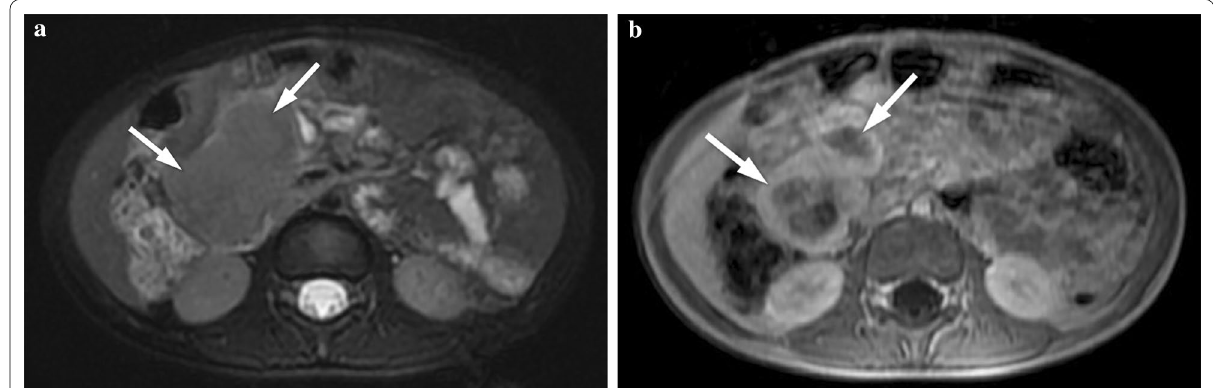
Fig. 6 a, b A 3-year-old girl with inflammatory pseudotumor. She had fever and weight loss for the last 3–4 months. In physical examination, a mass was detected in the abdomen. a Axial fat-saturated T2-weighted image shows hypointense tumor in the ileum (arrows). b Post-contrast T1-weighted axial image shows peripherally contrast-enhanced tumor with central necrotic parts (arrows). After biopsy, ALK and SMA positive inflammatory pseudotumor was